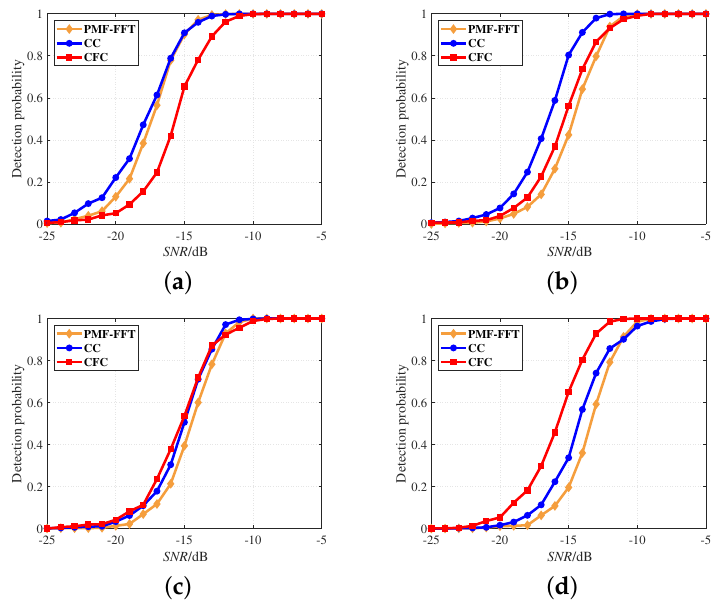
Figure 8. The detection probabilities of several algorithms with different SNR : ( a ) Doppler = 0 kHz; ( b ) Doppler = 26 kHz; ( c ) Doppler = 52 kHz; ( d ) Doppler = 78